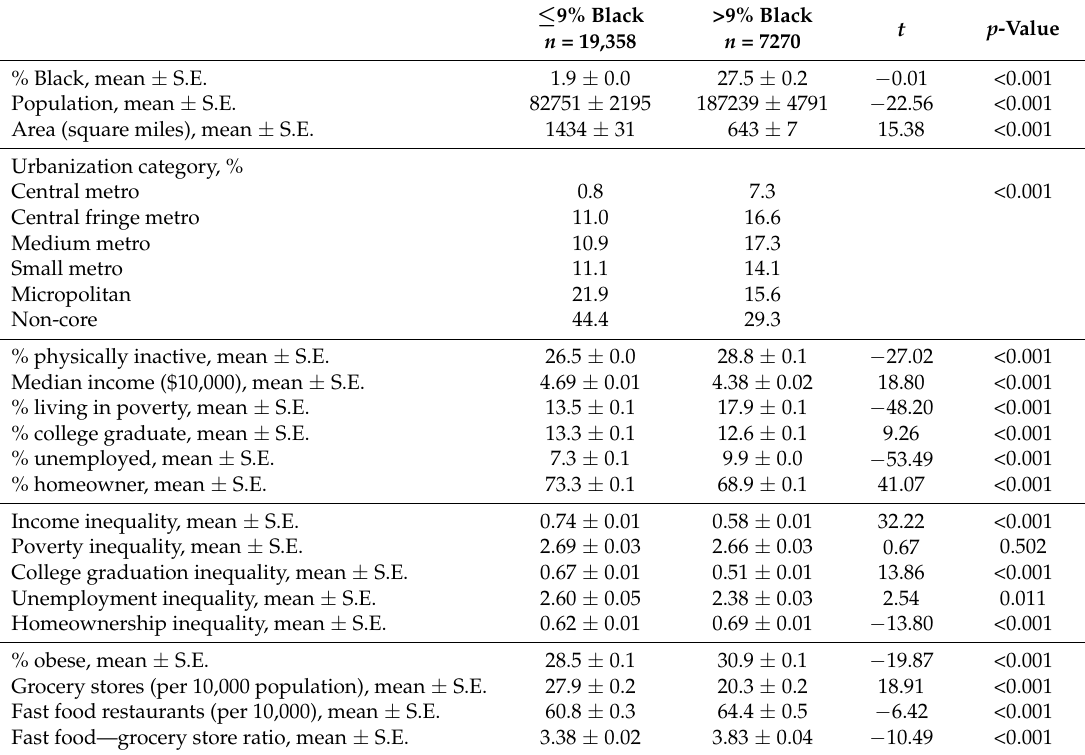
Table 1. County-level demographics, health–related resources, and indicators of structural racism by urbanization in the U.S. from 2007–2016. ≤ 9%